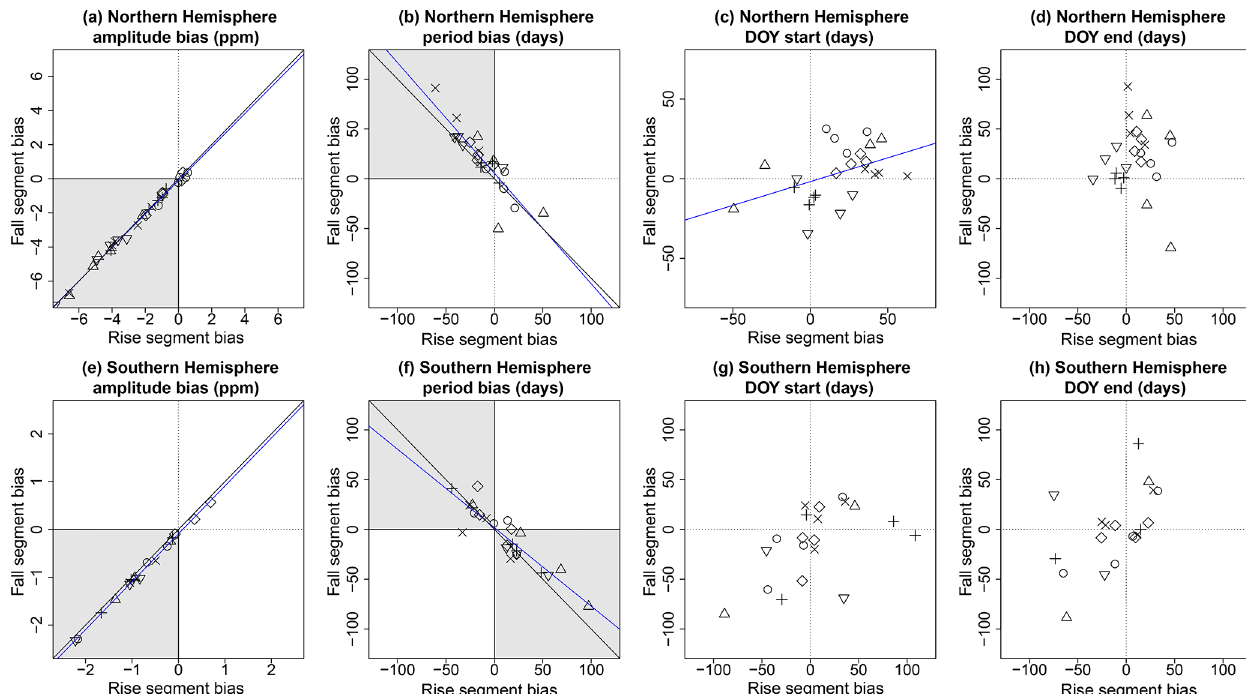
Figure 7. Emergent correlations among biases for rise ( x axes) and fall ( y axes) segment model biases, using GOSAT XCO 2 as a reference, for TransCom regions in the Northern Hemisphere (a–d) and Southern Hemisphere (e–h) . Data points are the average bias by model (unique symbols, not shown) for a particular region. Data for the Eurasia Boreal and Asia Tropical regions were excluded for lack of data in both rise and fall segments. Diagonal black lines are the 1:1 correspondence lines; blue lines are significant linear correlations.